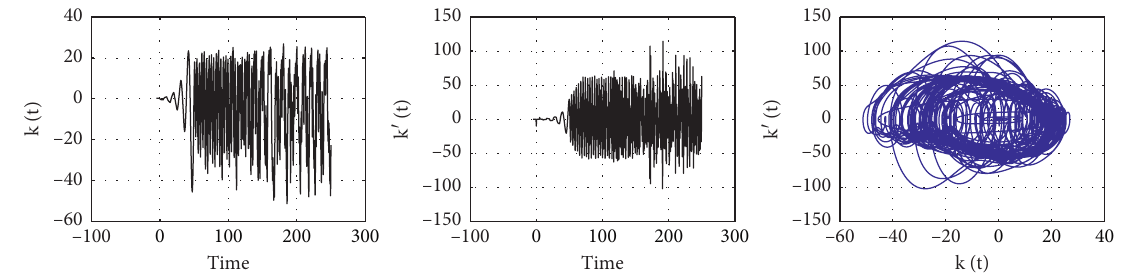
Figure 13: Solutions and phase trajectories at a � 0.125, q � 0.5, and τ � 5.